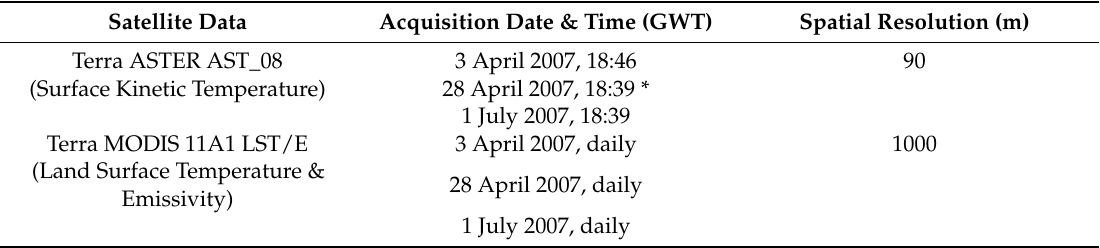
Table 1. Satellite images used in the study, their acquisition dates and spatial resolutions.